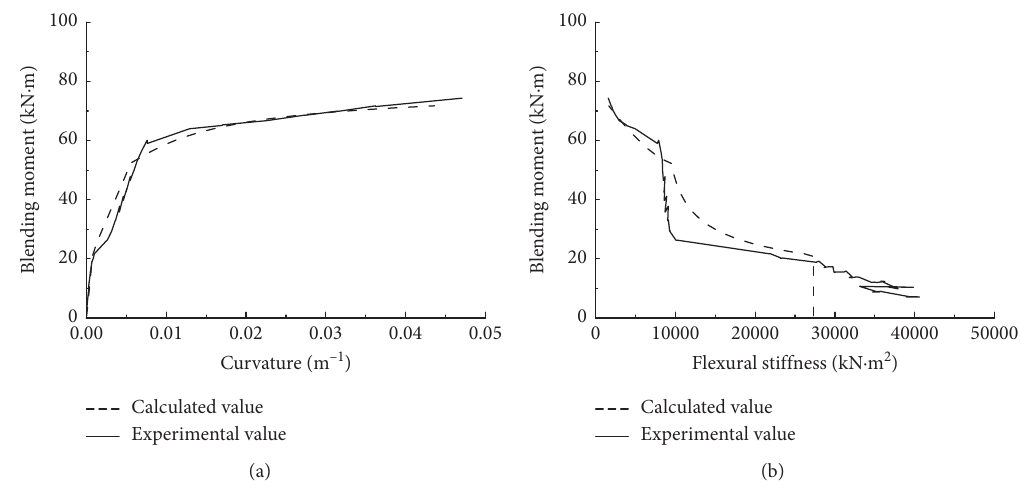
Figure 14: Beam B-0-30-4. (a) Bending moment-curvature curve. (b) Bending moment-stiffness curve.